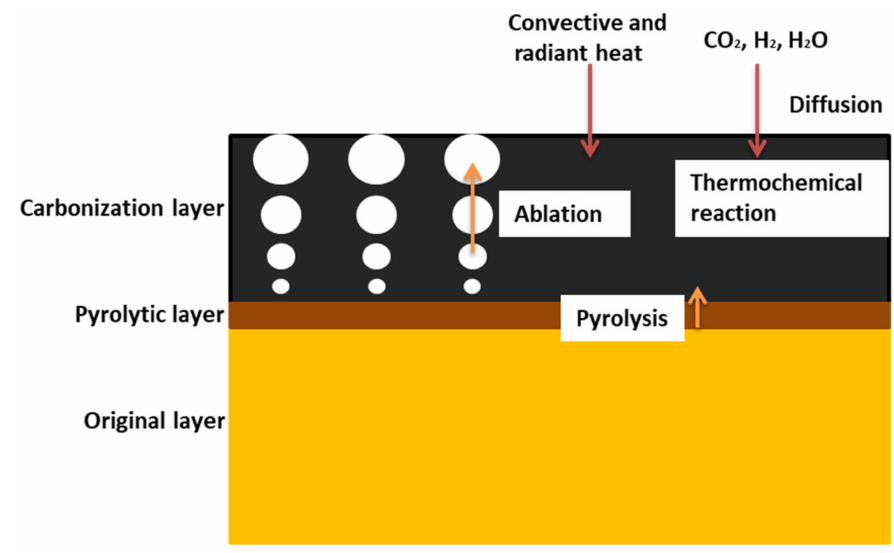
Figure 15. The thermochemical ablation model based on the porous carbonized layer